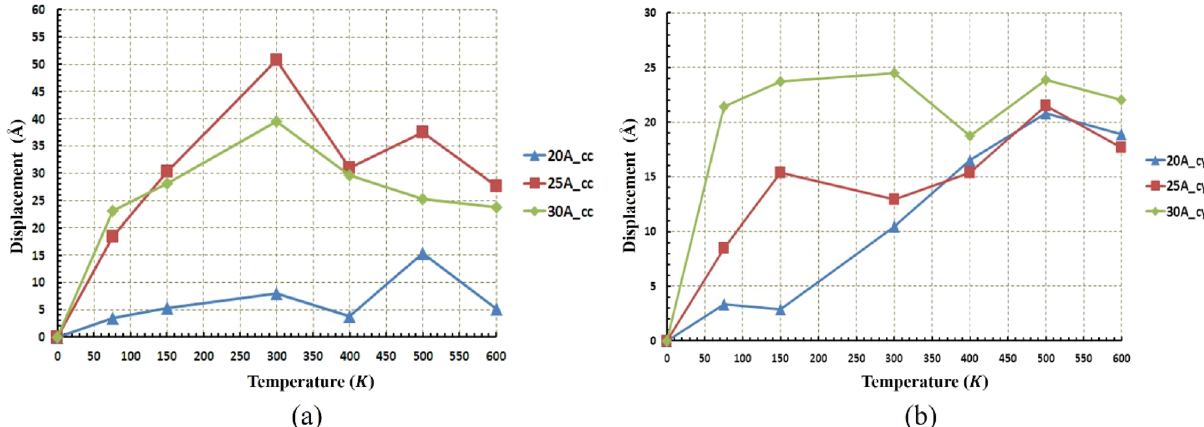
Figure 13. Displacement of the nanocar at different temperatures and radii ( a ) for the concave (cc) substrates ( b ) for the cylindrical (cy) substrates. The average displacement in concave geometry is higher than the cylindrical geometry. The maximum displacement of nanocar has occurred in the radius of 25 Å concave substrates and at 300 K